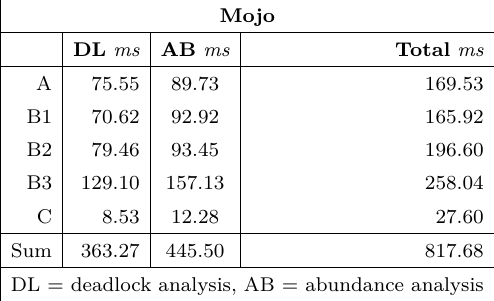
Figure 32. Analysis times for the library with